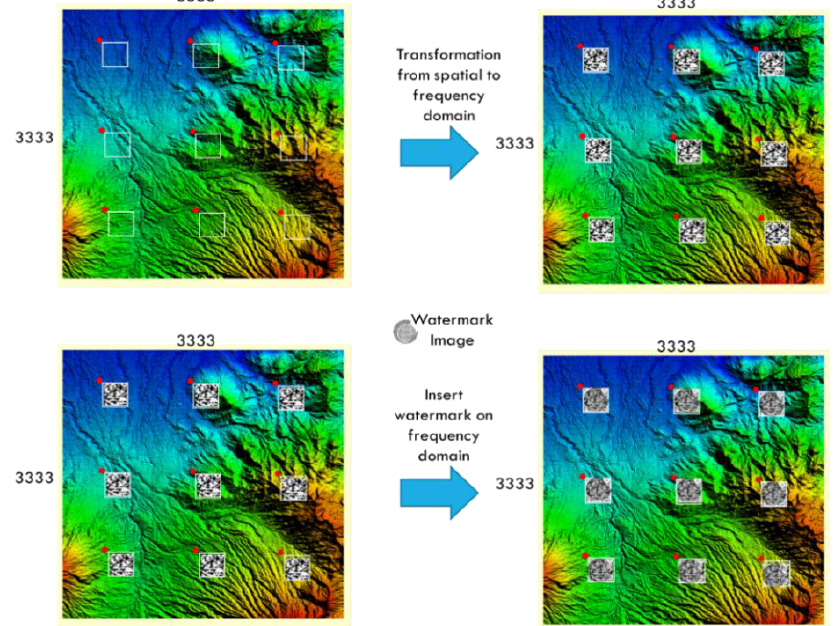
Figure 9. Macroblocks that are distributed at specific intervals on the one scene of GeoTIFF.